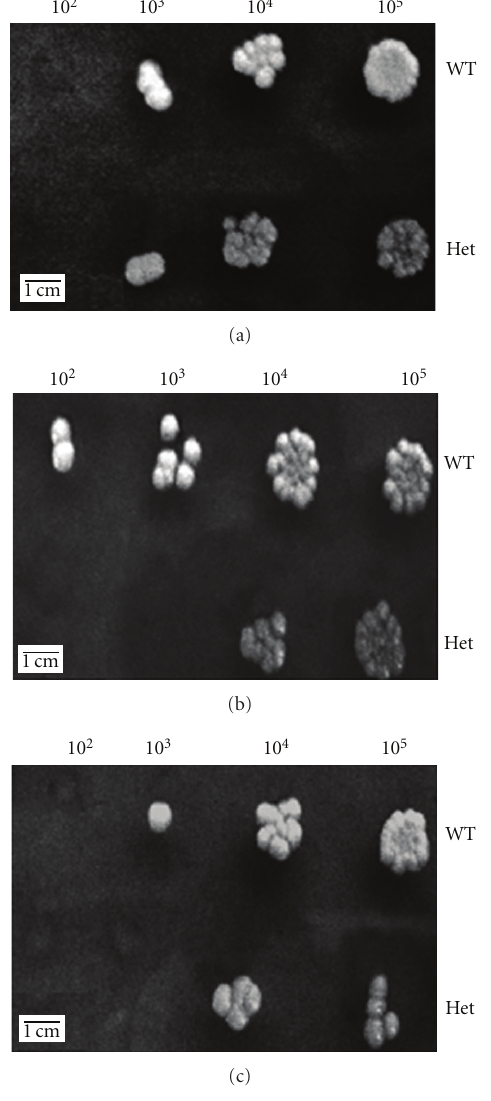
Figure 6: Oxidative stress assay. (a) Control plate; (b) 10mM con- centration of H 2 O 2 ; (c) 25 mM concentration of H 2 O 2 . Strains were grown in PDB, then diluted (10 5 to 10 2 cells/mL), and incubated with di ff erent doses of hydrogen peroxide for one hour. 5 μ L of the treated culture was spotted on PDA plates. Untreated cultures were also spotted as controls. Note the increased susceptibility of the mutant to hydrogen